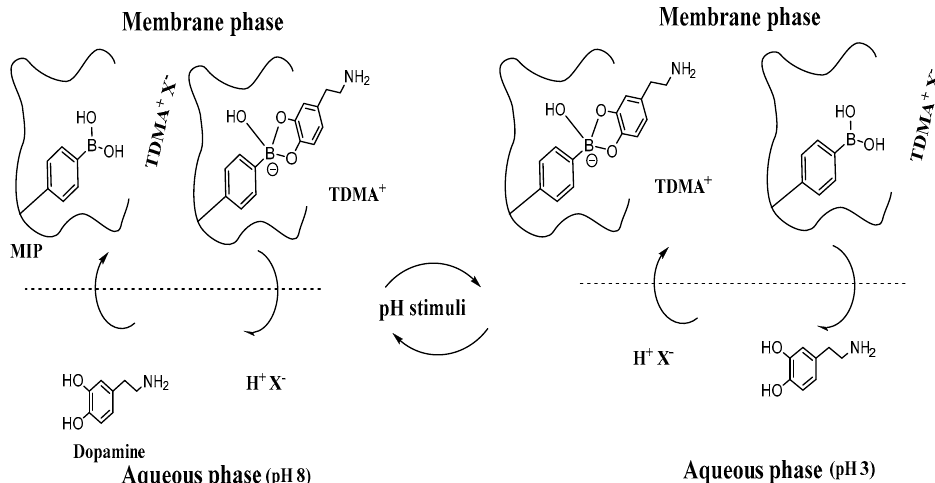
Figure 3. Proposed response and regeneration mechanism.